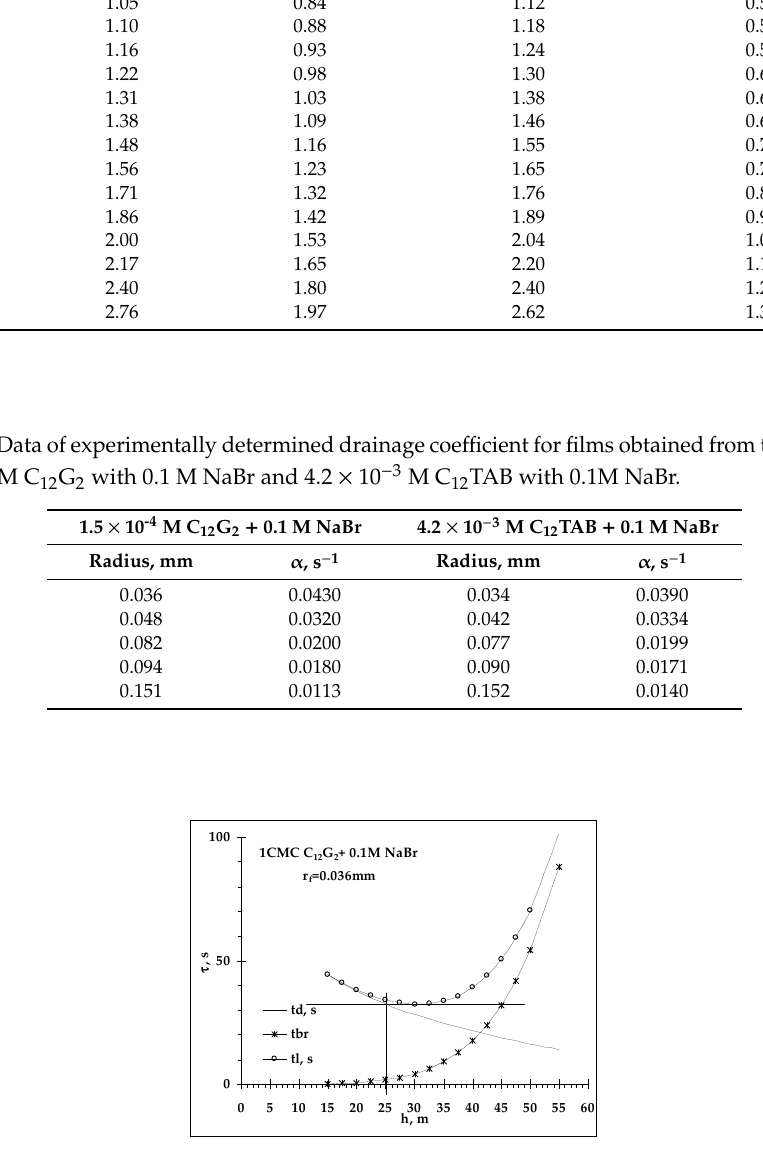
Figure A1. Dependence of the: time of the film drainage during the process of its fluctuation and destruction, including the time of film breakage and the lifetime of the thinning film on the thickness [ τ d = τ d ( h ) calculated by Equation (7), τ br = τ br ( h ) calculated by Equation (5) using the non-retarded Hamaker constant, and τ l = τ l ( h ) calculated similar to a sum from τ d and τ br